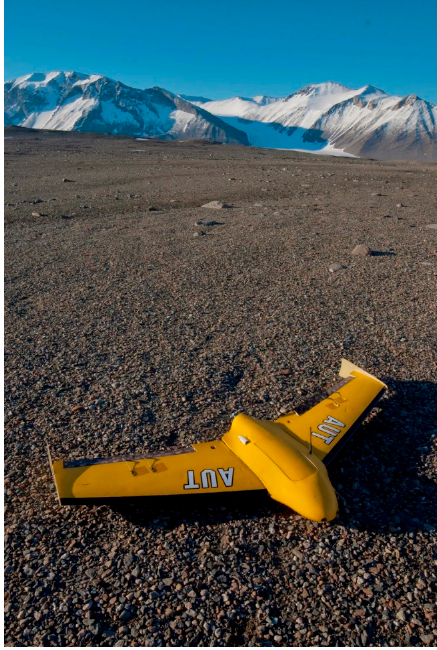
Figure 2. PolarFox UAV (Skycam UAV Ltd., Dunedin, New Zealand) can be hand launched with a bungee cord. It is equipped with a parachute for landing [44].